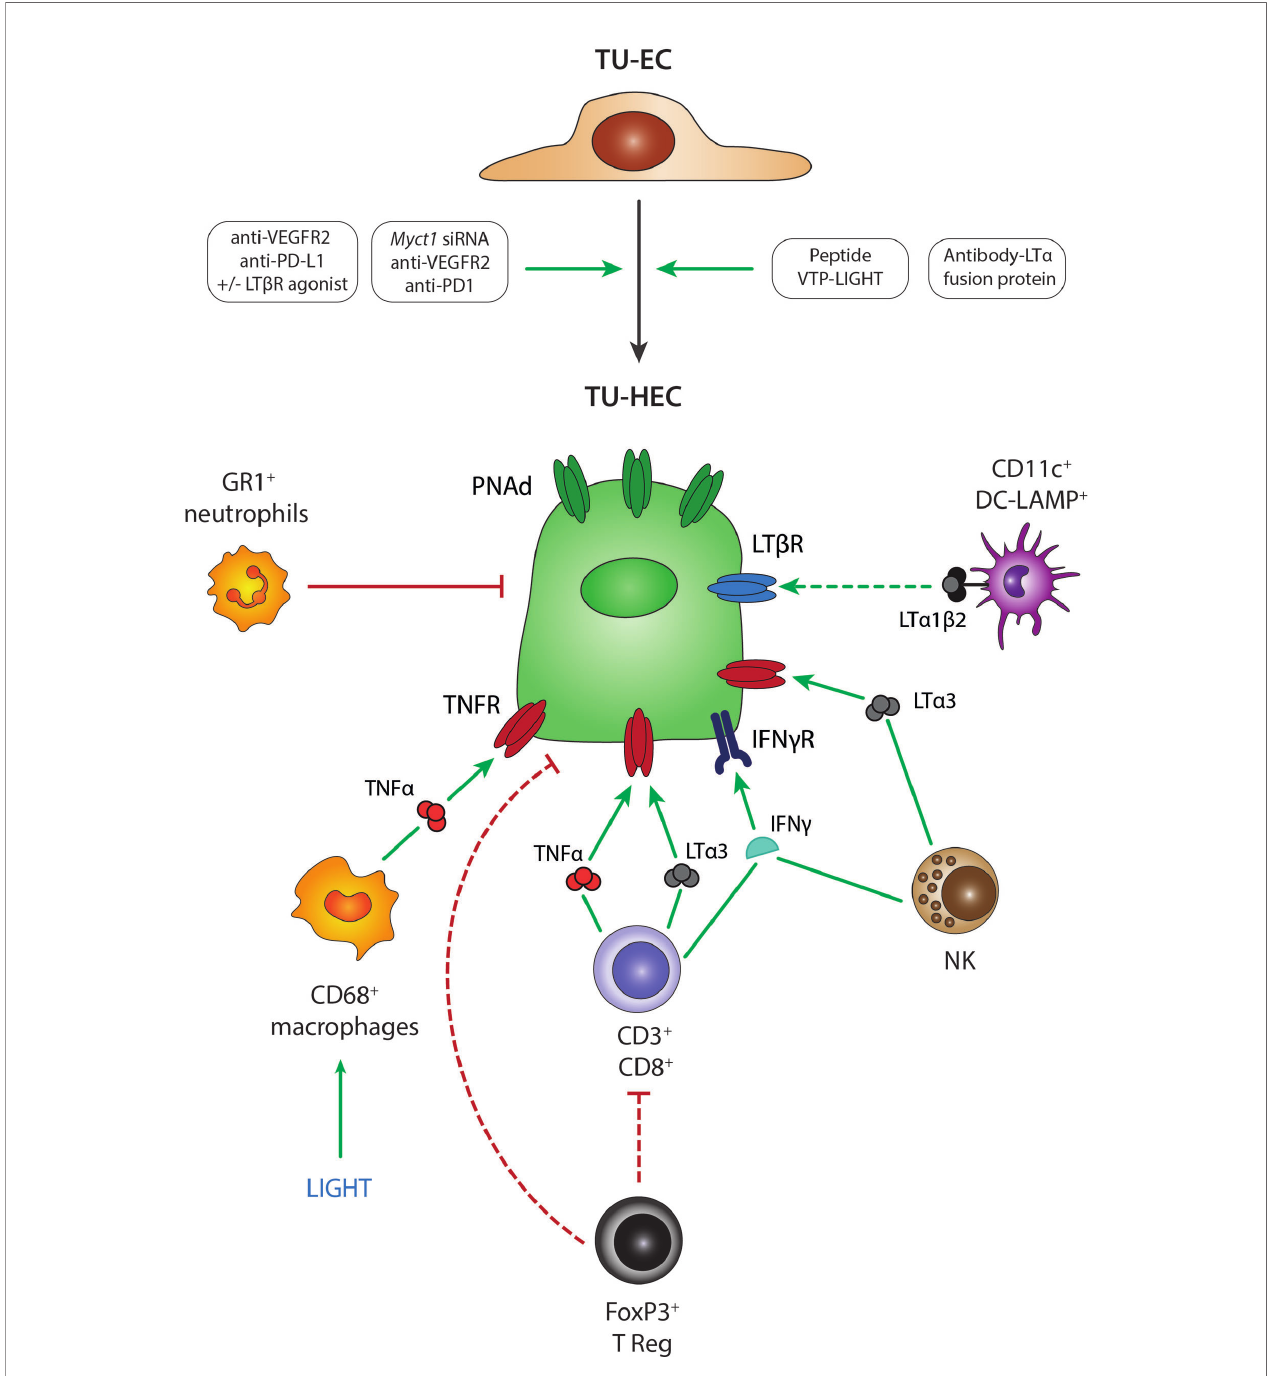
FIGURE 2 | Mechanisms of TU-HEV formation and maintenance. Several treatment regimens in mouse model studies have demonstrated the transition from TU- ECs to TU-HECs expressing PNAd; including 1- the combination of anti-VEGFR2 anti-angiogenic therapy with anti-PD-L1 immunotherapy, 2- the single activation of the LT b R axis with LT b R agonists, 3- the triple combination of anti-VEGFR2 anti-angiogenic therapy with anti-PD-L1 immunotherapy and LT b R agonists, 4- the triple combination of anti-VEGFR2 anti-angiogenic therapy with anti-PD1 immunotherapy and Myct1 siRNA-mediated silencing, 5- engineered EC-speci fi c VTP peptides expressing LIGHT and 6- fusion protein antibodies delivering LT a to the tumors (antibody-LT a fusion protein). TU-HECs are regulated by speci fi c immune cell types and signaling cues within the tumor microenvironment; including 1- CD3 + /CD8 + T cells via TNF a , LT a 3 and IFN g , 2- FoxP3 + Tregs that either directly regulate PNAd expression or indirectly by exerting an immune-suppressive effect on CD3 + CD8 + T cells, 3- NK cells via LT a 3 and IFN g , 4- CD11c + DC-LAMP + DCs via membrane- bound LT a 1 b 2, 4- LIGHT-induced CD68 + macrophages via TNF a and 5- GR1 + neutrophils. TU-EC, tumoral endothelial cell; TU-HEC, tumoral high endothelial cell; PNAd, peripheral node addressin; DC, dendritic cell; NK, Natural Killer